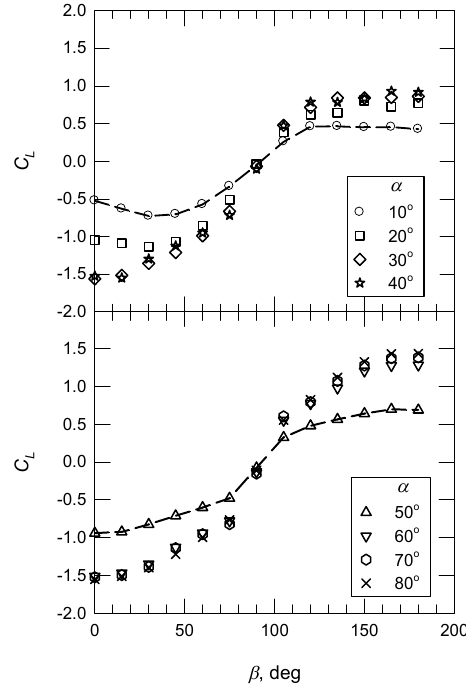
Figure 15. Uplift coe ffi cient for a specific value of α .